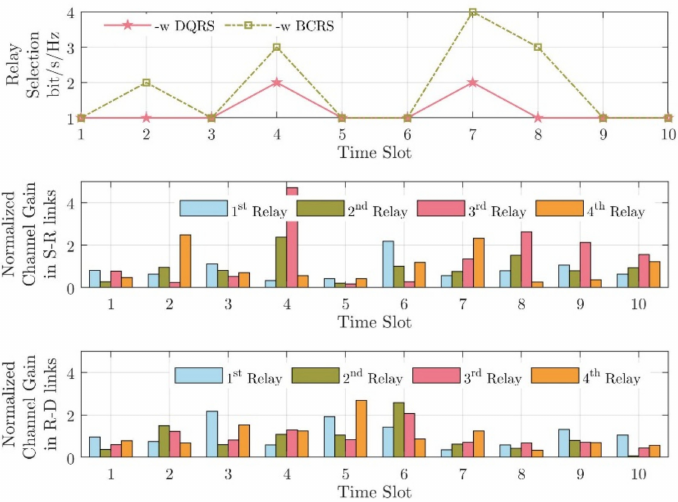
Figure 5. An example of relay selection in 10 TSs.